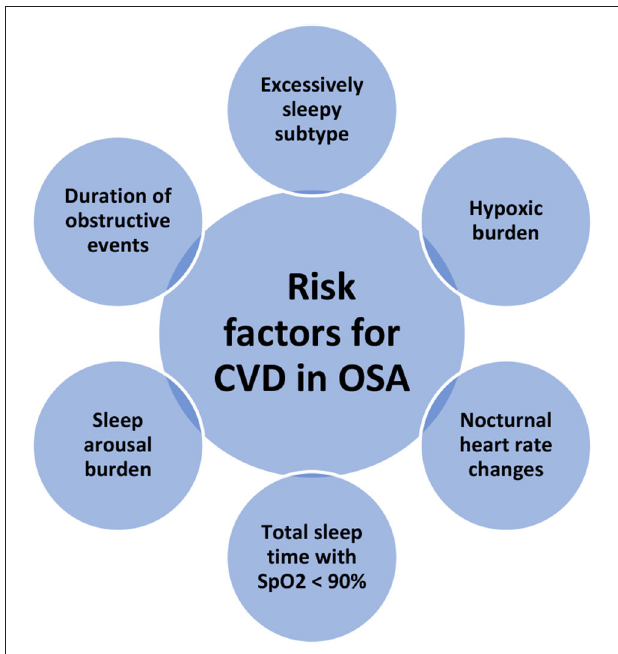
FIGURE 1 | Variables impact the relationship between OSA and cardiovascular disease